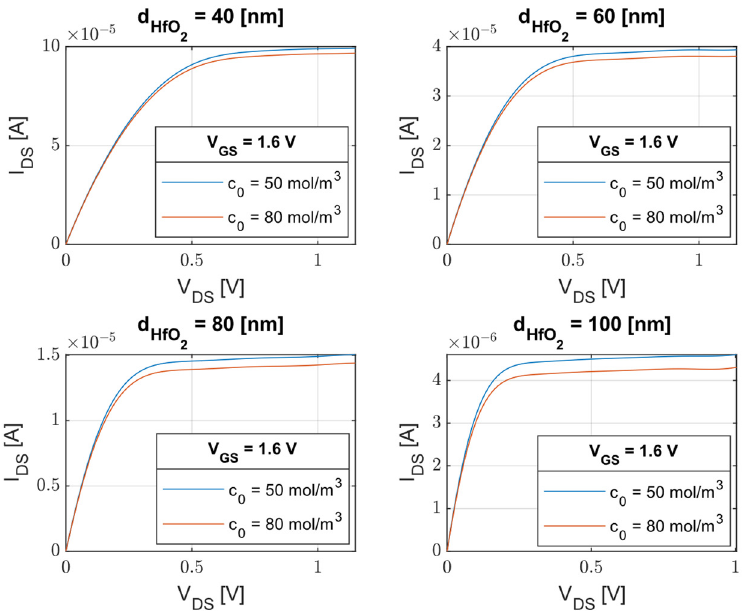
Figure 6. Drain-source current vs. drain-source voltage for two different Cl − values using various values of HfO 2 ’s thickness .